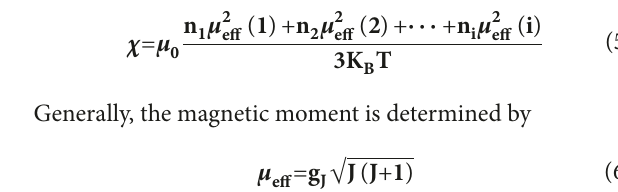
Figure 8: The magnetic susceptibility ( 𝜒 ) and inverse magnetic susceptibility ( 1/𝜒 ) measurements as a function temperature of LiGd 0.98 Eu 0.02 (PO 3 ) 4 .